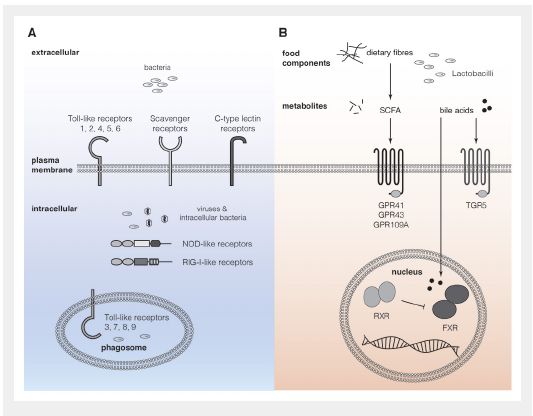
Not only conserved structural motifs of microorganisms, but also bacteria-derived metabolites are recognised by the host immune system. A. Pattern recognition receptors, such as Toll-like receptors, the scavenger receptors, the C type lectins, the RIG-I- like or the NOD-like receptors recognise pathogen-associated molecular patterns, which are highly conserved structural motifs or molecules common to microbes and viruses. B. Intestinal bacterial consortia metabolize food products and bile acids to short chain fatty acids (SCFA), secondary bile acids or vitamins. The G protein coupled receptor (GPR) recognizes SCFA, the intracellular farnesoid X receptor (FXR) and the transmembrane G coupled receptor 5 (TGR5) sense secondary bile acids and retinoic acid is recognized by the retinoid X receptor to modulate host